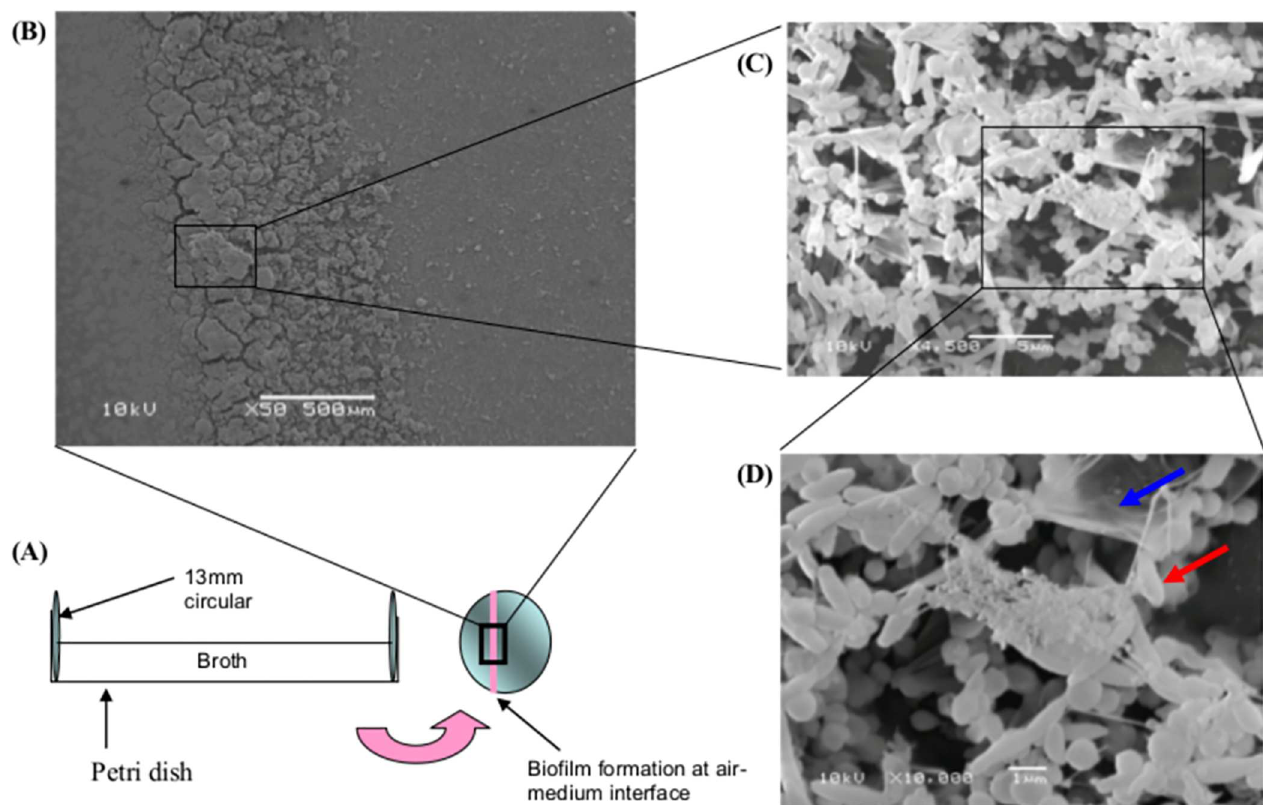
Fig 1. SEM of H . pylori biofilm strain 26695 on coverslip. (A) Diagrammaticillustrationof H . pylori biofilm formation on coverslip.(B) Section of H . pylori at the air medium interface, showingbiofilm formation on day 14 (x50). (C) Enlargedsection of H . pylori biofilm formed at the air medium interface (x4,500). (D) Enlargedsection of H . pylori biofilm showingthe presence of film like structures (x10,000). Blue arrow indicatethe film-like structures postulatedto be exopolysaccharides and red arrow indicate spiral H . pylori .